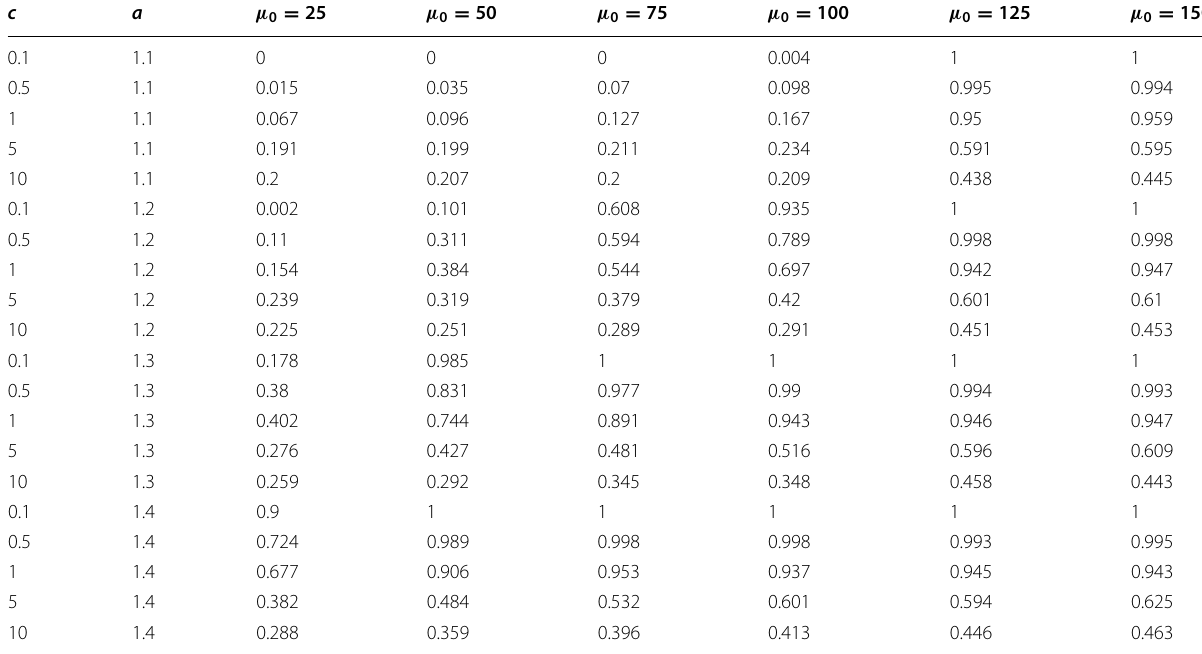
Table 2 PROB of the CPCAT (increasing